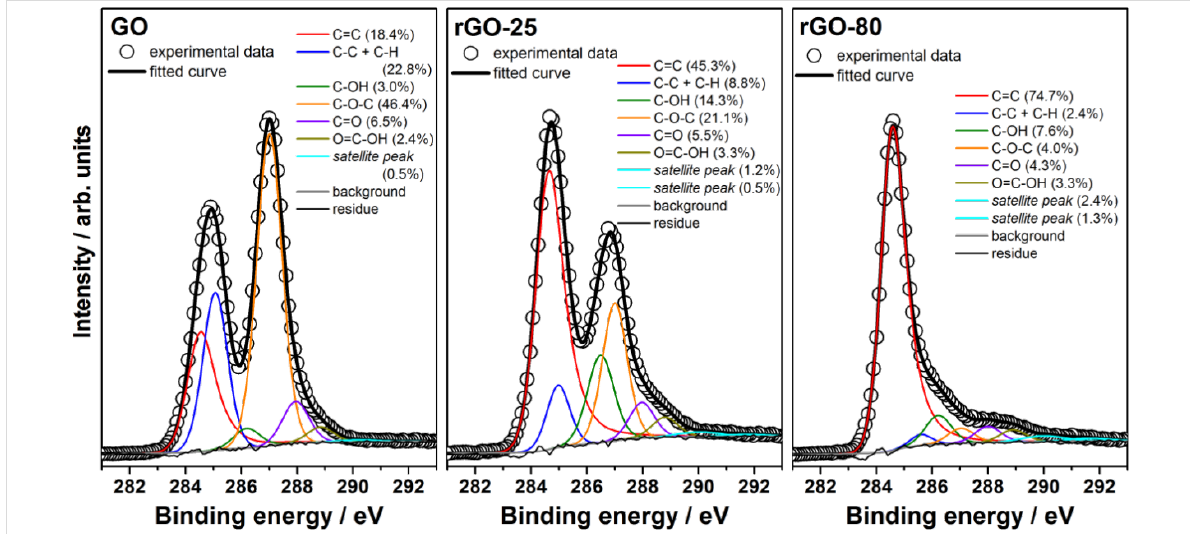
Figure 4: XPS spectra at the C 1s core level of GO and rGO samples prepared by reactions at 25 °C for 7 days or at 80 °C for 3 h (rGO-25 and rGO-80, respectively).